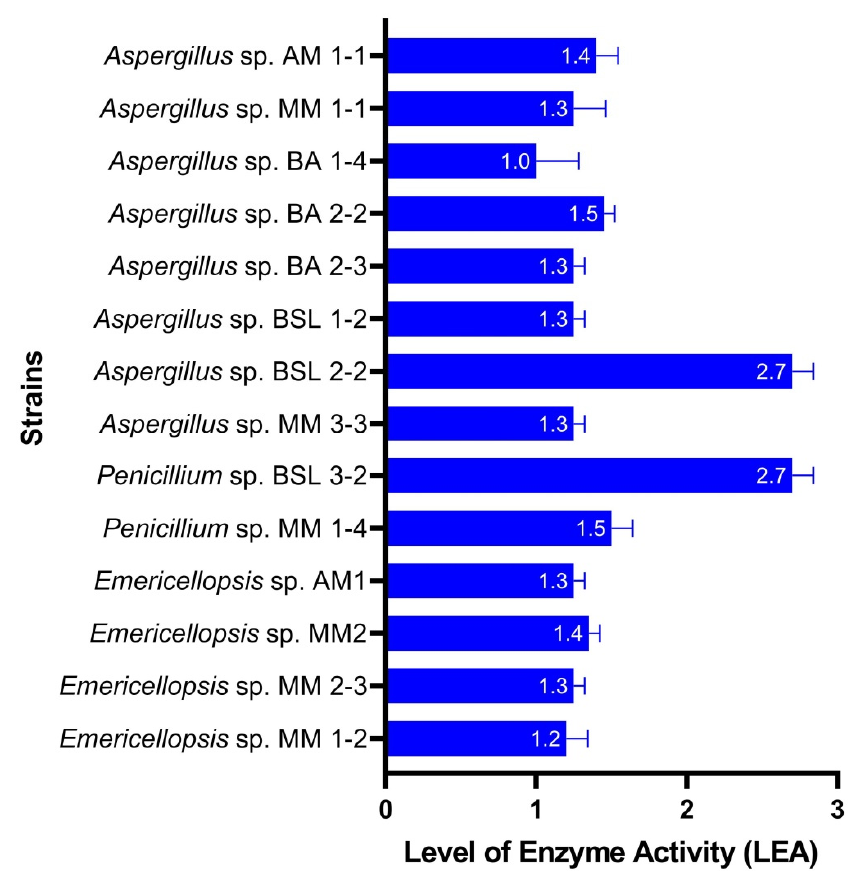
Figure 4. Level of lipase activity of fungal isolates (plate Figure 4 . Level of lipase activity of fungal isolates (plate assay).